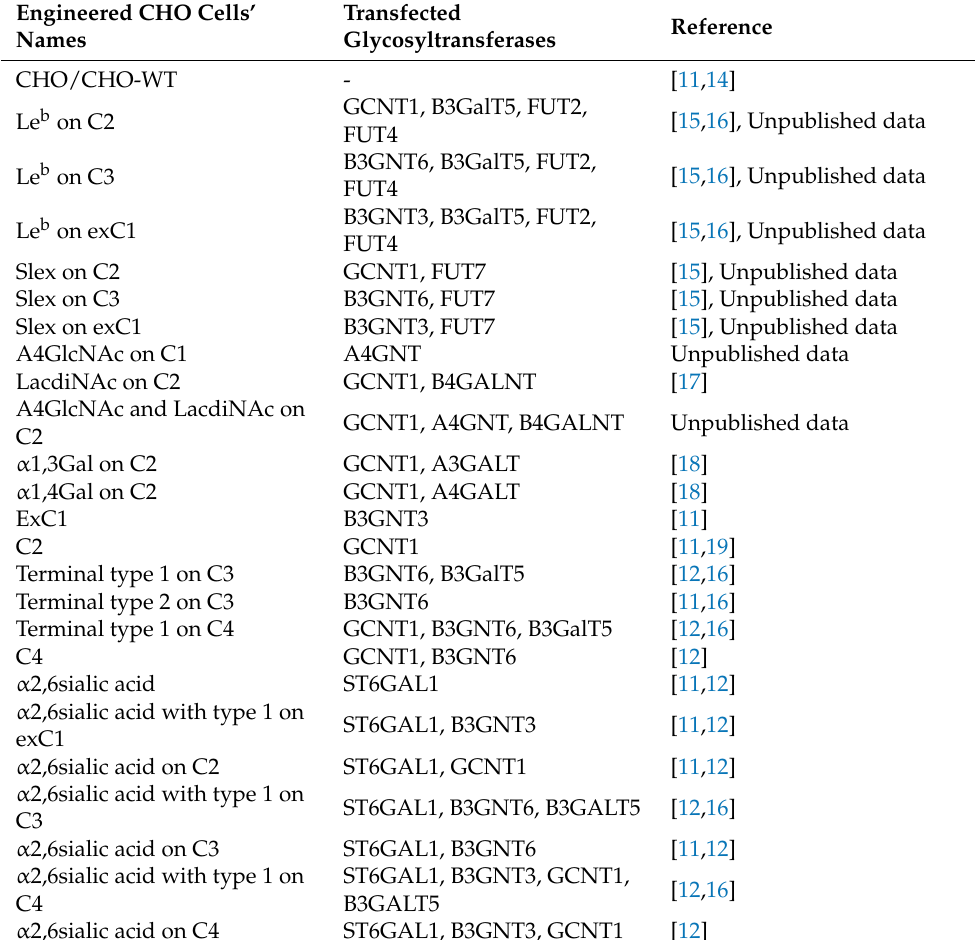
Table 1. 25 CHO cells transfected with combinations of glycosyltransferases. CHO/CHO-WT: